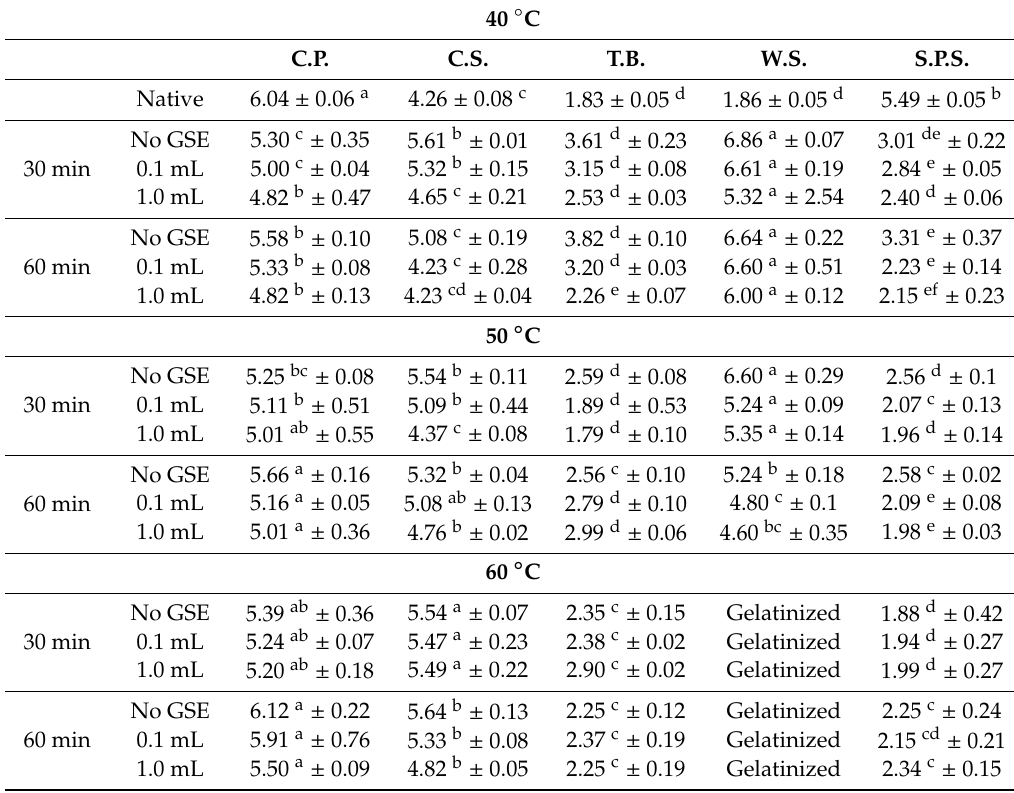
Table 3. E ff ect of germinated sorghum extract (GSE) on the swelling power of starch granules ( g / g